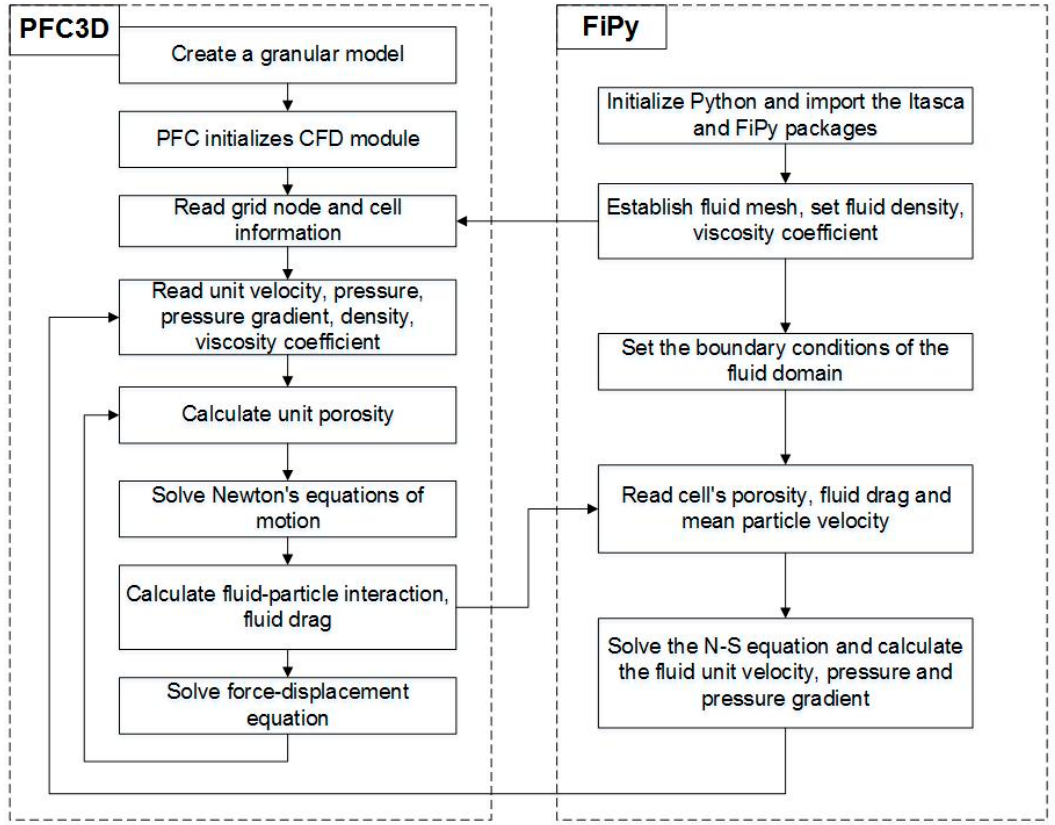
Figure 3. Coupling mode and information exchange process of the two components.